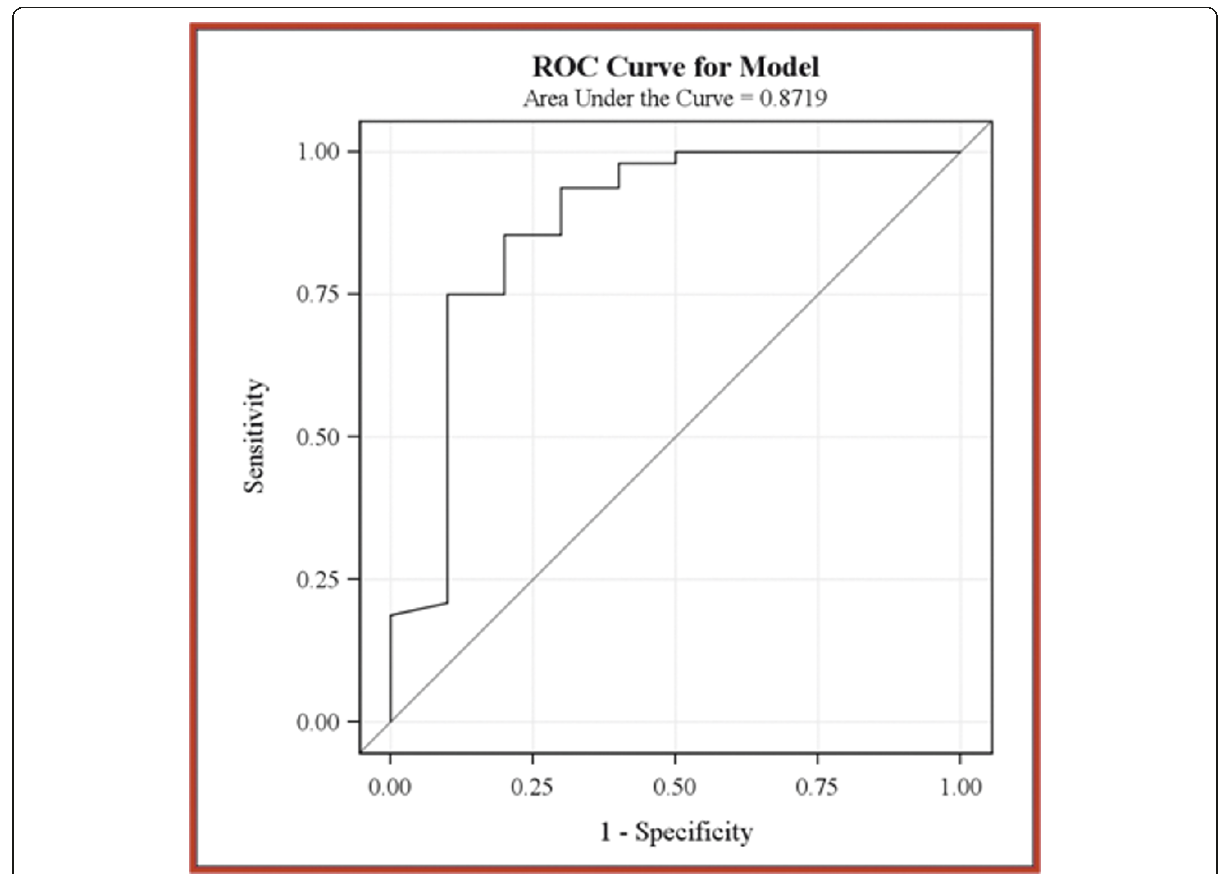
Figure 2 ROC curve analysis for Ki67 and TUNEL immunostaining in predicting positive or negative SCCA immunostaining .